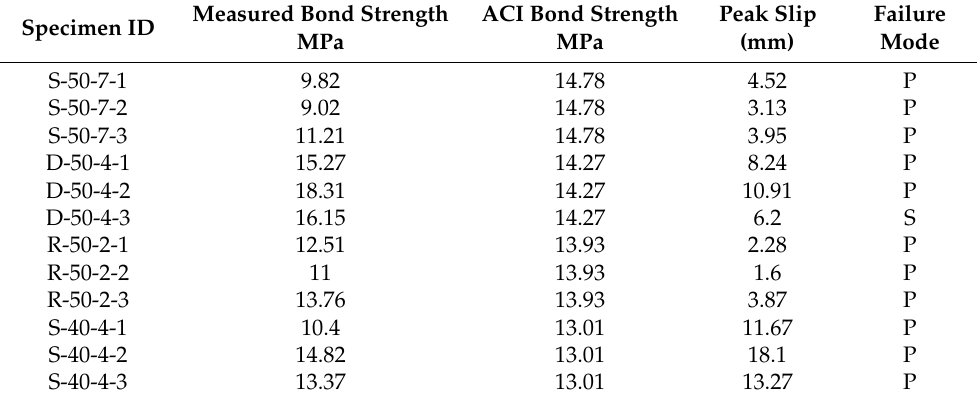
Table 4. Test results for pull-out specimens.